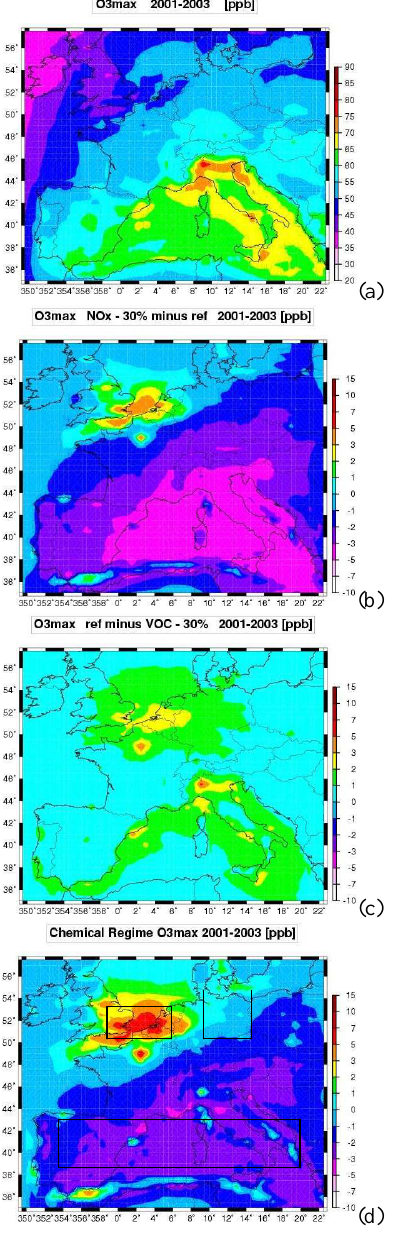
Fig. 1. Reference simulation and reduced emission simulations for average daily ozone maxima for three summers (May to Au- gust) 2001–2003; (a) reference simulation, (b) difference between 30% reduced anthropogenic NO x emission and reference scenario, (c) difference between reference and 30% reduced anthropogenic VOC emission and reference scenario, (d) chemical regime map: difference between a 30% reduced NO x and a 30% reduced VOC emission scenario. Note that differences between the scenario run and the reference are inverted in (c) with respect to (b), because this allows simply adding (b) and (c) in order to obtain the chemi- cal regime. (d) Also shows delimitations of the three domains over North-Western Europe, over North-Eastern Germany and over the Mediterranean basin that will be used for analysis of the chemical regime temporal variability (see Fig.